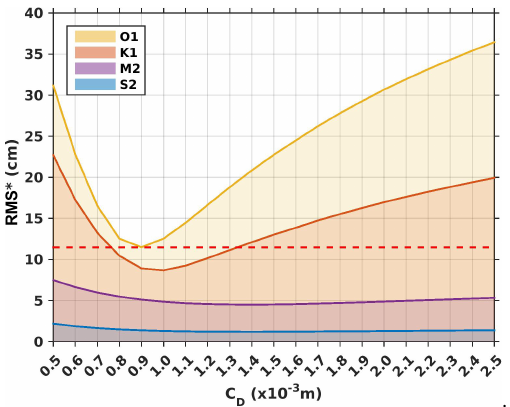
Figure 10. Model complex errors (Appendix; Eq. A2) relative to al- timetry data for tests performed with varying the values of the uni- form z 0 over the domain (SET2). The space in between two lines corresponds to the error for each wave. The yellow line corresponds to the cumulative errors for all four waves. The dashed red line cor- responds to the smallest cumulative error, here equal to 10.96cm and obtained for z 0 = 1 . 5 × 10 − 5